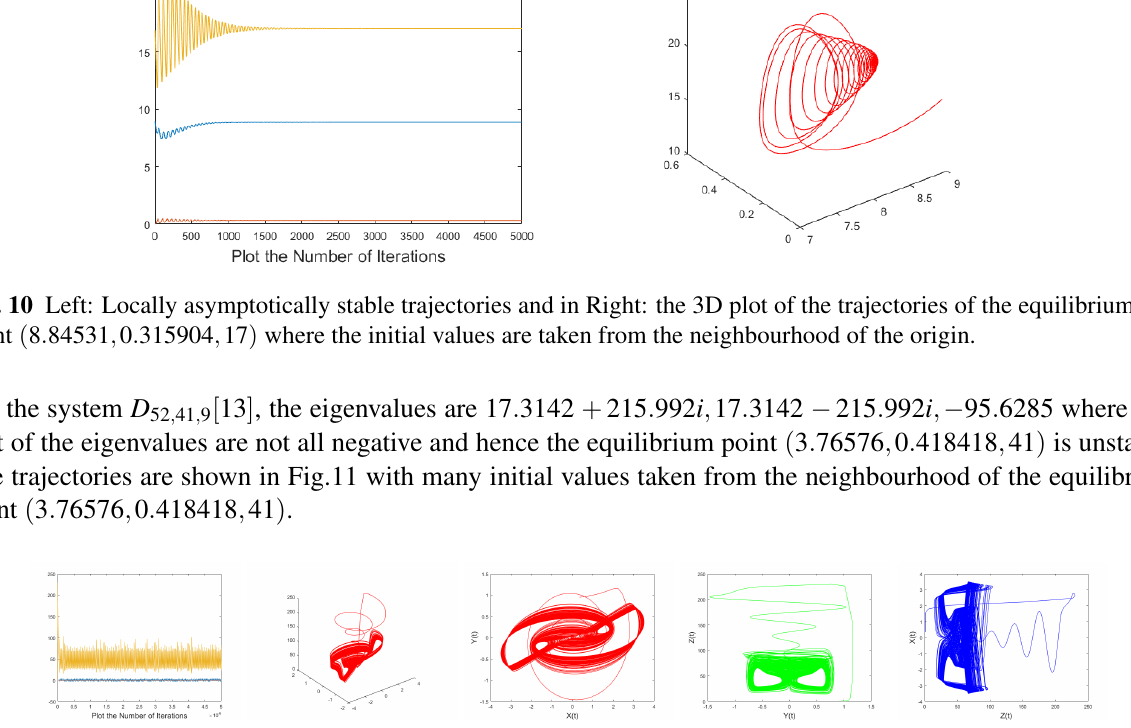
Fig. 11 Unstable trajectories which are away from the equilibrium point ( 3 . 76576 , 0 . 418418 , 41 ) in the system D 52 , 41 , 9 [ 13 ]